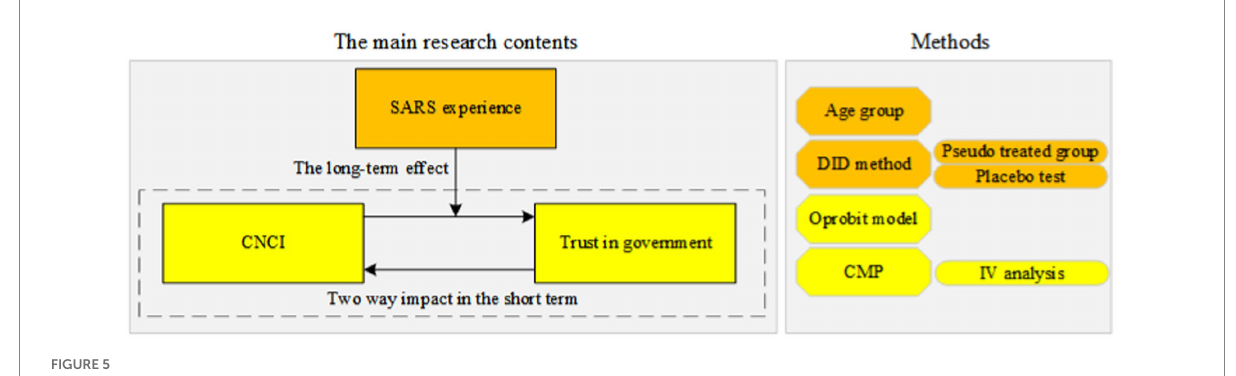
FIGURE 5 Logical relations and